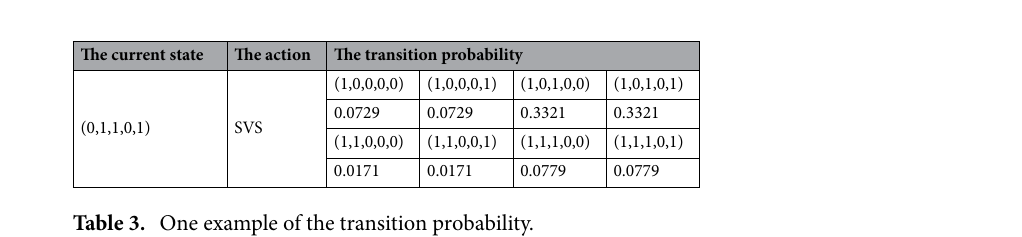
Table 3. One example of the transition probability.